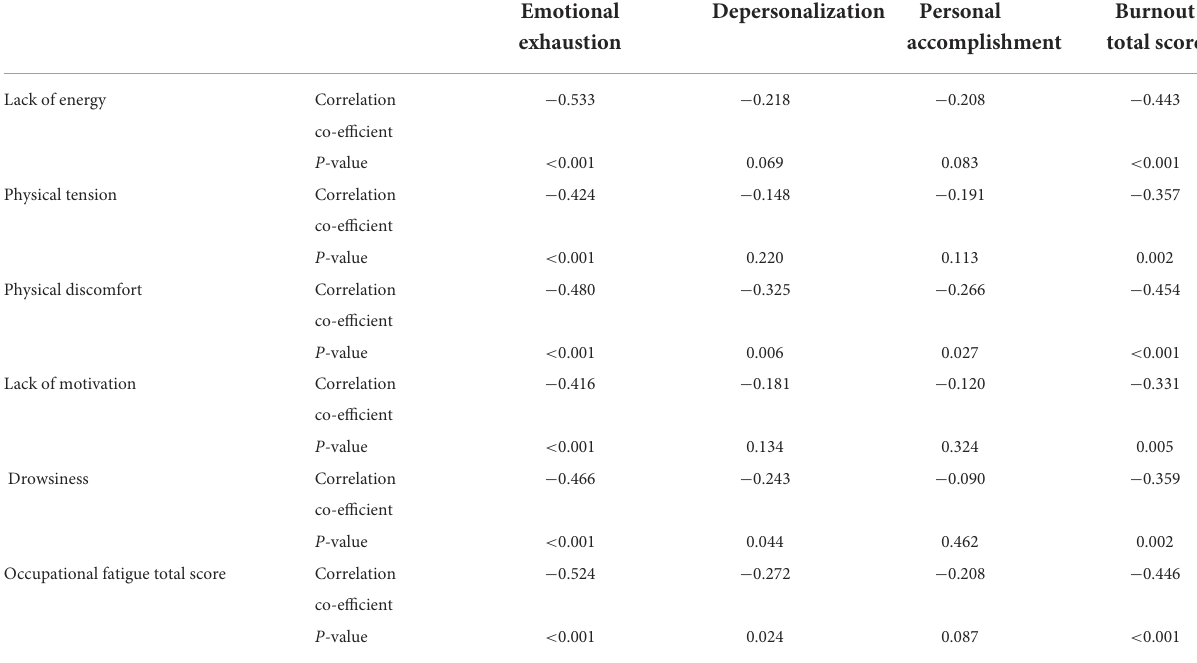
TABLE 3 Evaluation of the relationship between the dimensions of the burnout inventory and the dimensions of the occupational fatigue